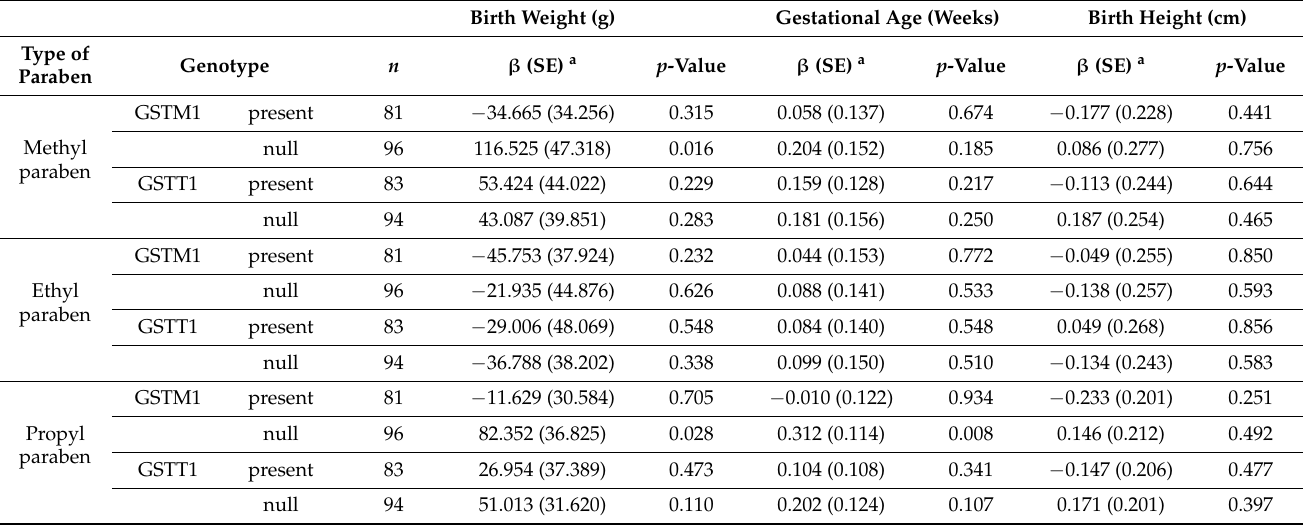
Table 4 shows the significant relationships between paraben levels and birth outcomes according to GSTM1/GSTT1 genotypes. Significant positive relationships of birth weight with methyl and propyl paraben concentrations in mothers with the null GSTM1 genotype were found. Moreover, the null GSTM1 genotype was significantly associated with gesta- tional age and propyl paraben concentration. The relationships of the interaction between GSTM1 and methyl paraben concentrations with birth weight were significant. However, the interaction between GSTT1 and the paraben level was not significant (Table S2). Table 4. Regression coefficients and 95% confidence intervals for urinary paraben concentrations associated with birth outcomes according to GSTM1/GSTT1 genotype.